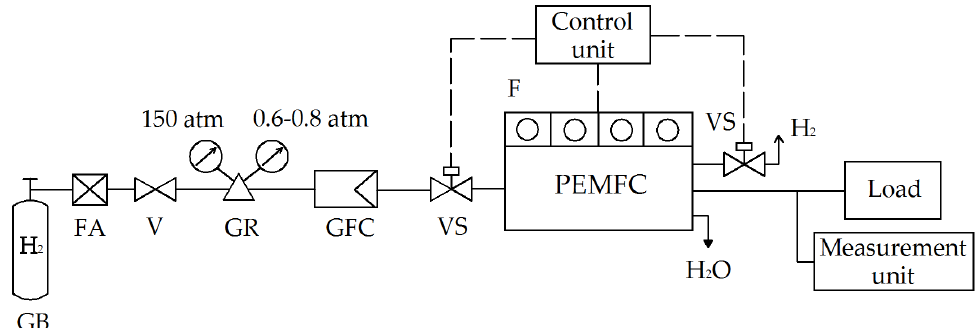
Figure 4. Block diagram of a fuel cell test bench: GB—gas balloon, FA—flashback arrestor; V—valve; GR—gas regulator; GFC—gas flow controller; VS—valve solenoid; F—fan.